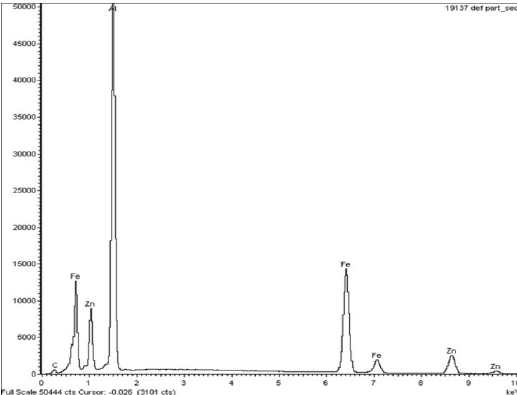
Figure 20. Spectrum of the chemical composition of the top-dross particle found in the zinc